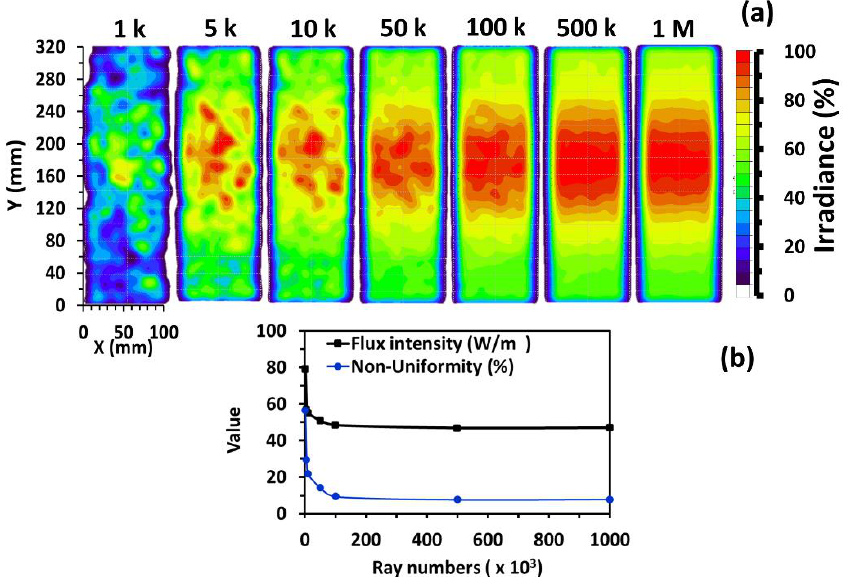
Figure 5. The irradiance maps ( a ) of different ray numbers (from 1 k to 1 M rays); the color scale bar shows the irradiance between 0% and 100% of the maximum irradiances. ( b ) The maximum flux intensity and the nonuniformity of irradiance as a function of ray numbers.